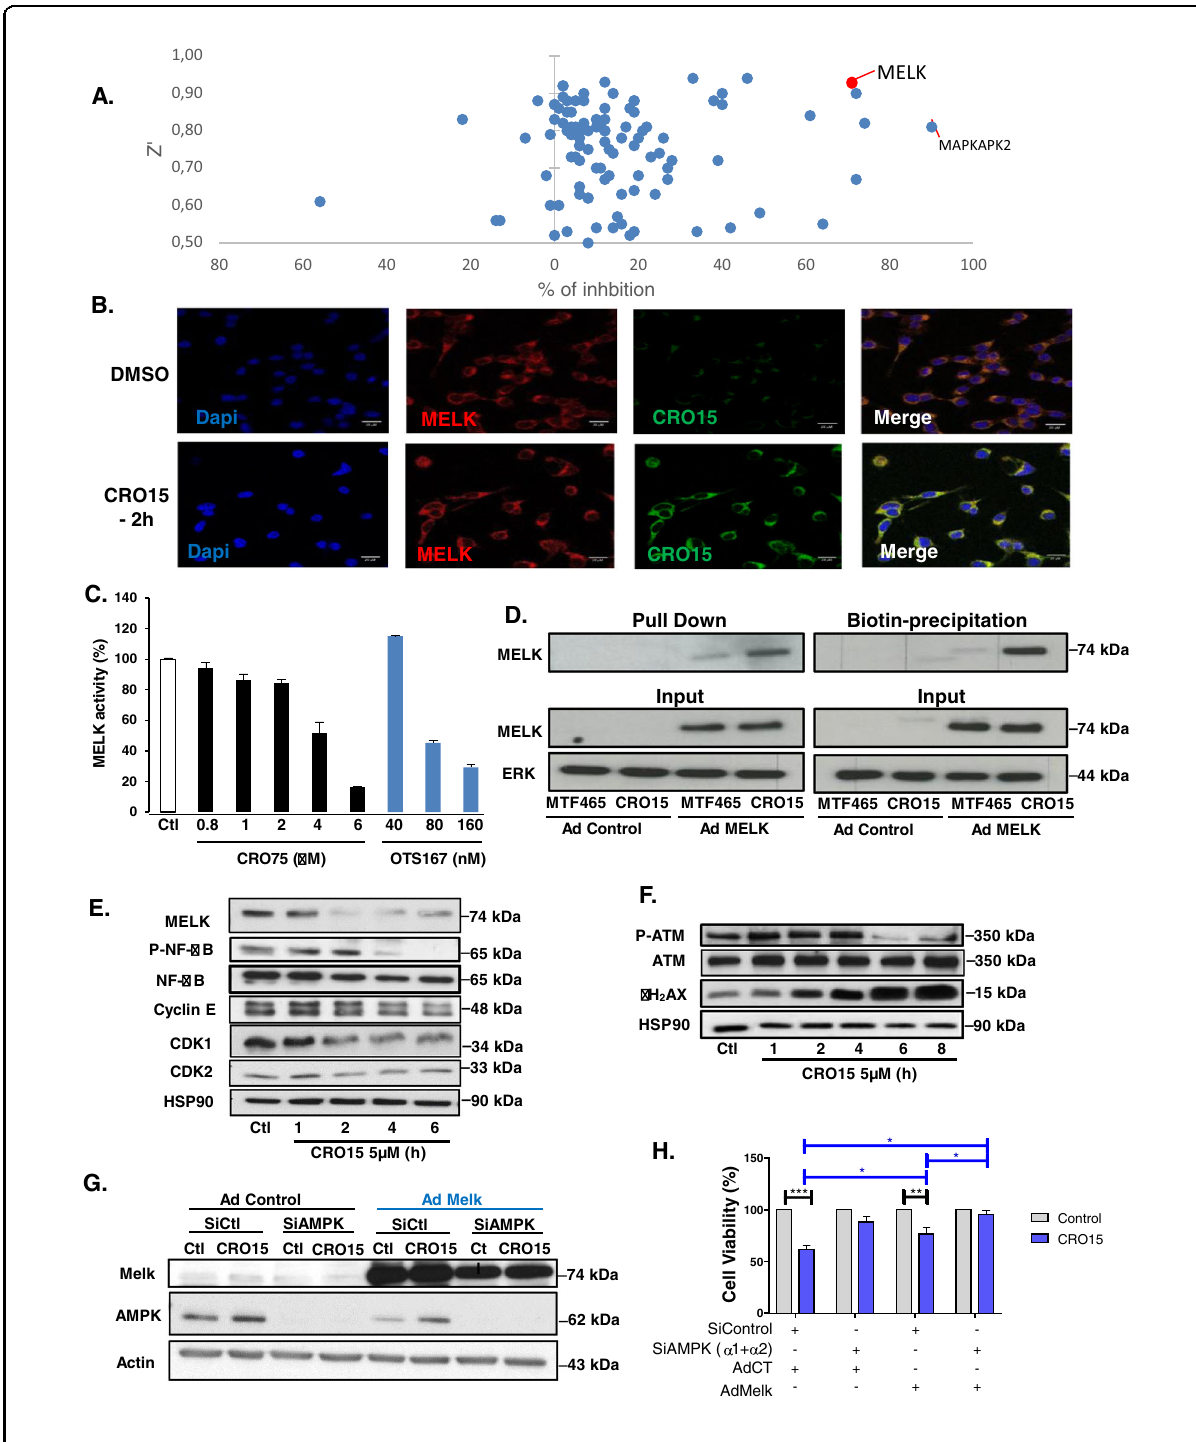
Fig. 3 (See legend on next